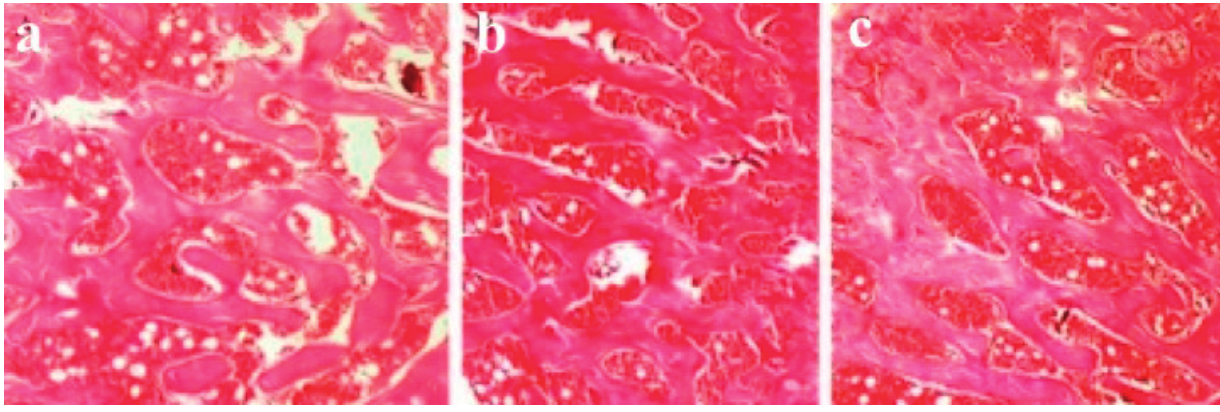
Figure 6. Hematoxylin and eosin staining of bone sections of left femur subcapital region; ( a ) In Group A, trabecular walls are thinner than in other groups ( b ) Group B; ( c ) Group C